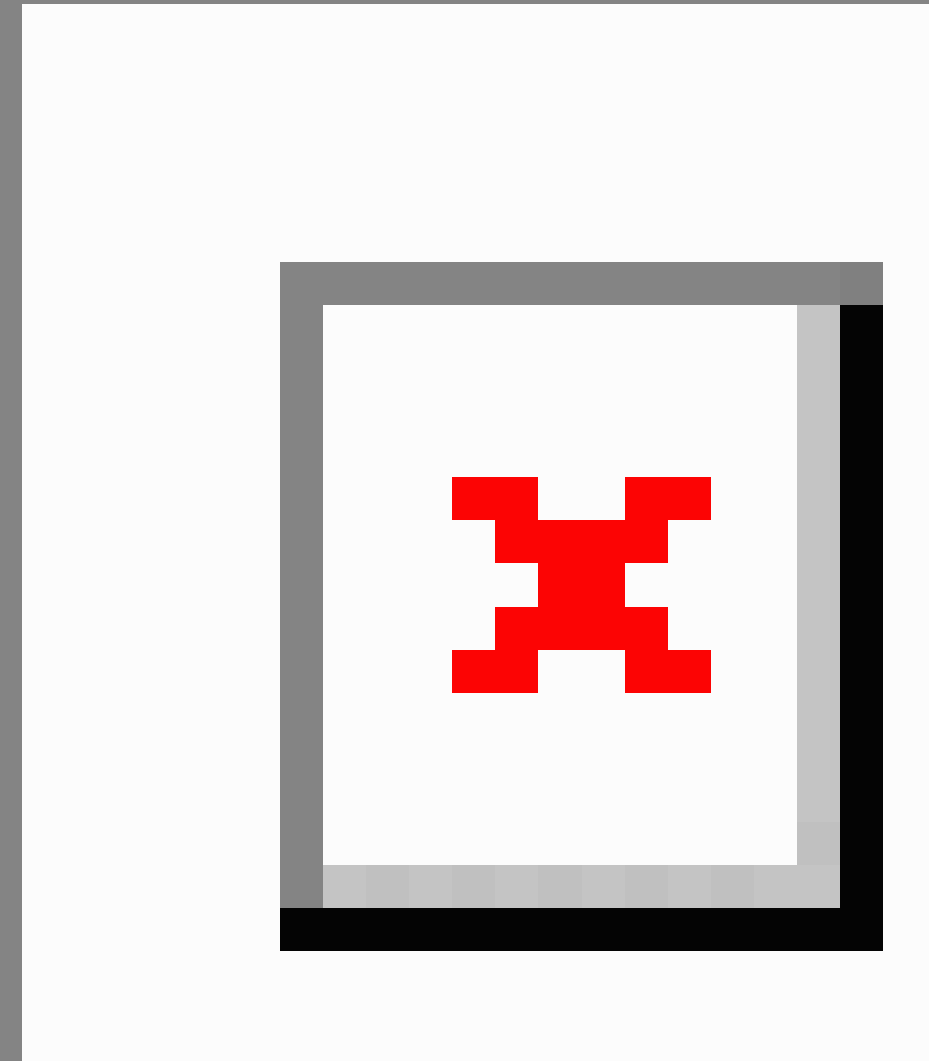
Figure 4. Formula of Mascha and